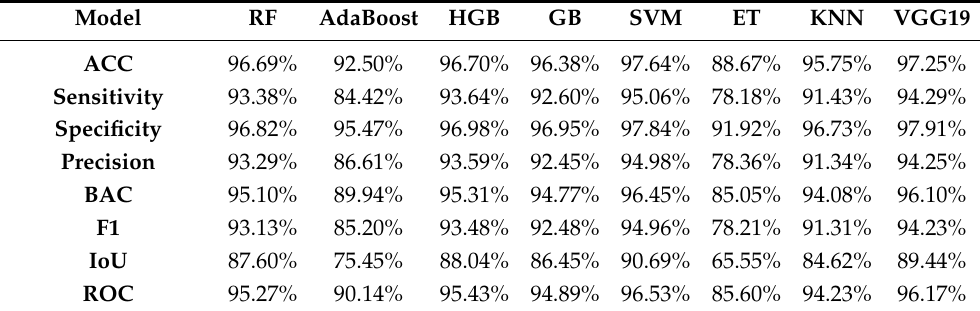
Table 5. The reported results concerning the “Monkeypox Skin Images Dataset” (MSID) after optimizing three machine learning classifiers on the extracted and processed features beside the results of the VGG19 model.